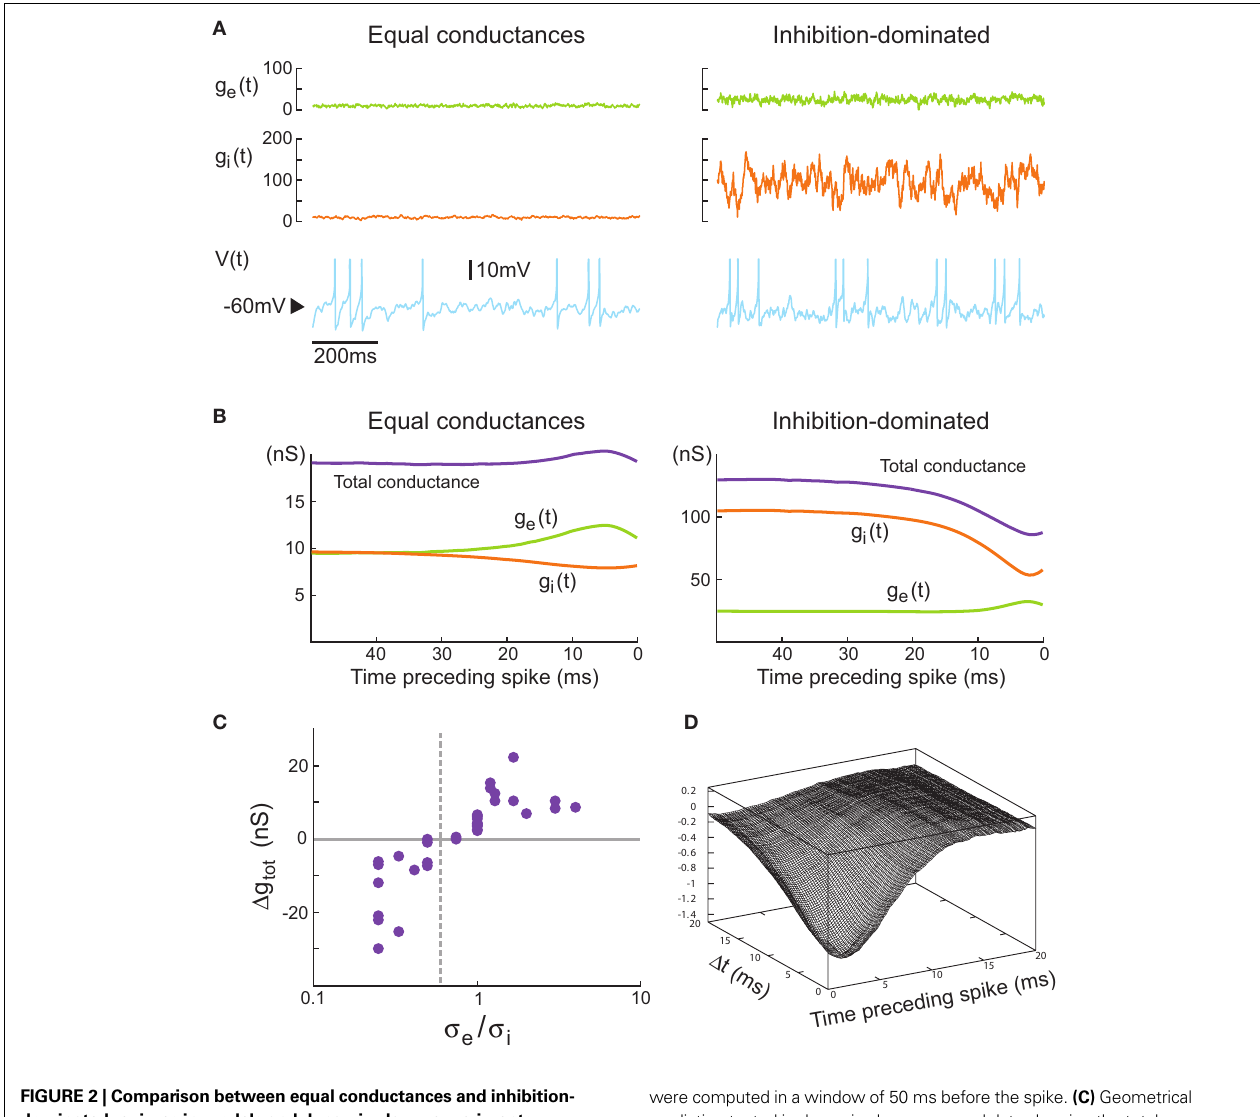
= g = 10 nS, σ = σ = 2.5 nS) e0 i0 e i = 25 nS, g = 100 nS, σ = 7 nS e0 i0 e